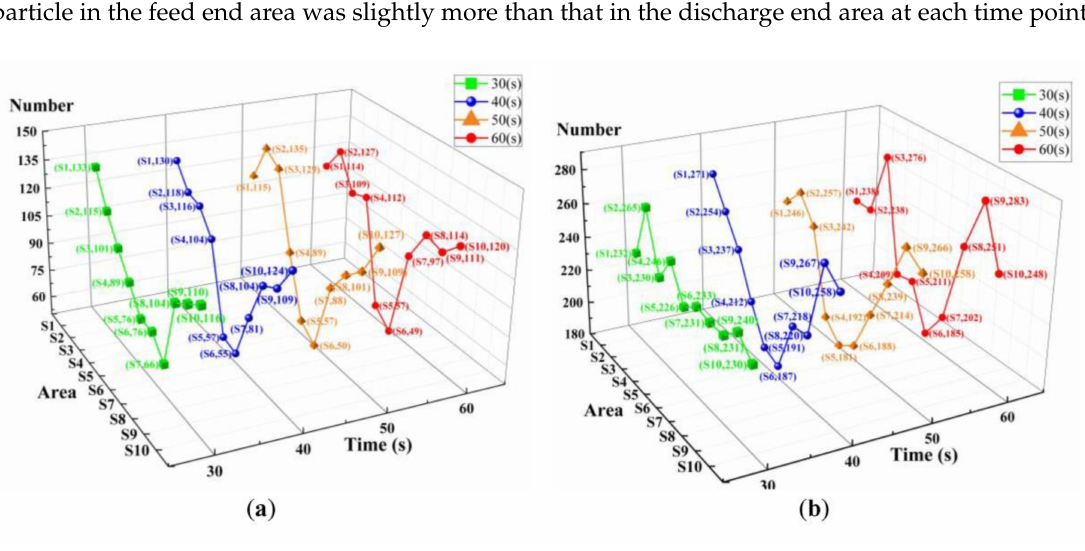
Figure 7. ( a ) The number of 150 mm steel balls distributed in each area at each time point. ( b ) The number of 130 mm steel balls distributed in each area at each time